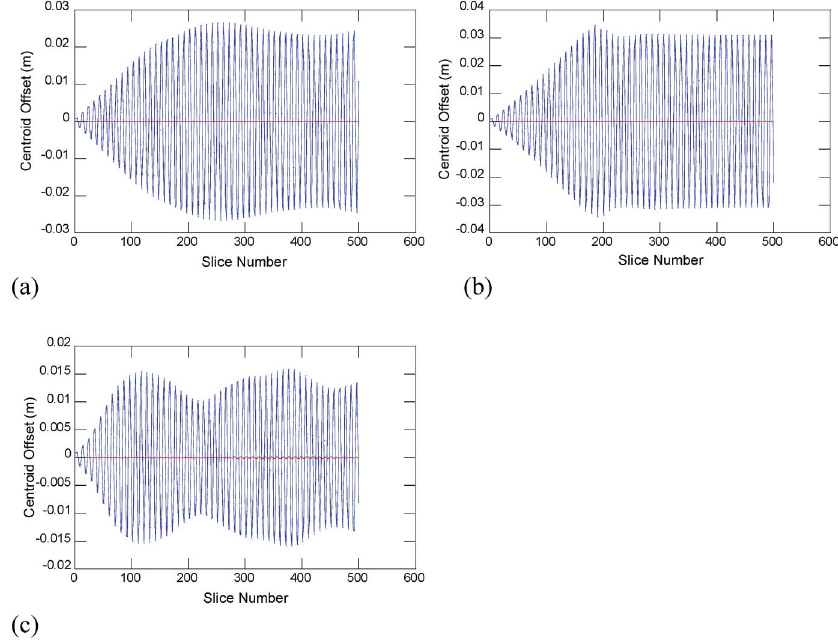
FIG. 20. (Color) Ion centroid evolution for 20-MeV, 3-cm beam case at different axial positions. Each slice is 4 nsec long. The red line is for the horizontal offset and the blue line is for the vertical offset. (a) z (cid:4) 1 : 25 m , (b) z (cid:4) 2 m , and (c) z (cid:4) 5 m .